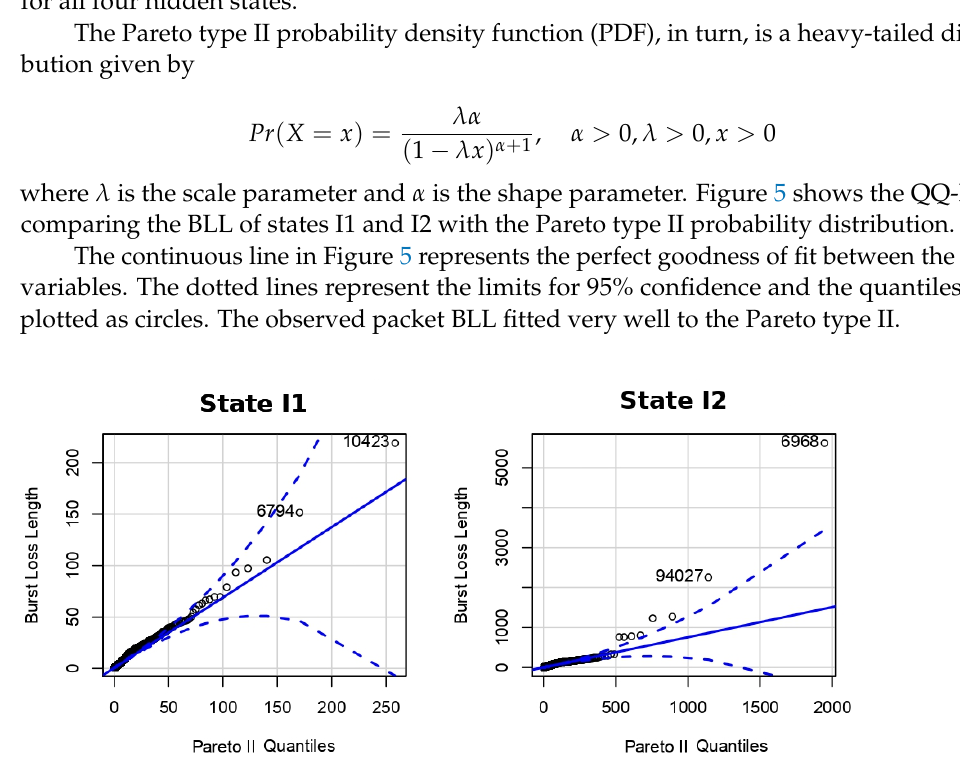
Figure 5. QQ-Plot for states I1 and